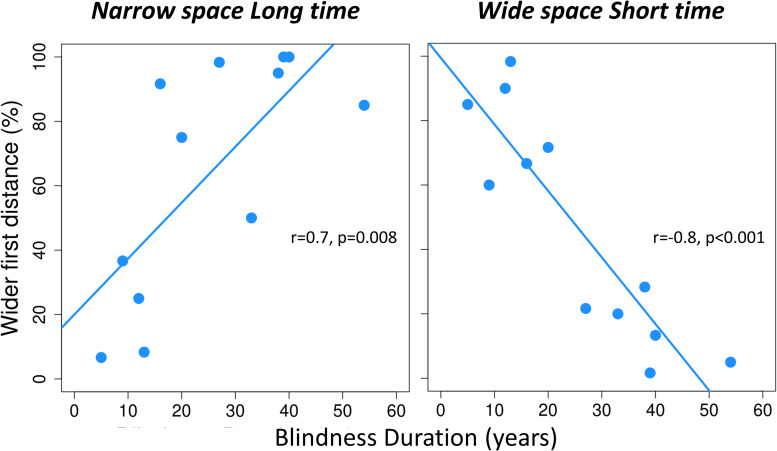
For each conflicting condition of the spatial bisection task, the perceived localization of S2 is plotted against years of blindness duration. For each conflicting condition (narrowSpace_longTime, wideSpace_shortTime), percentage of trials in which the first distance is reported as wider (i.e., perceiving S2 as played from the right) is plotted against years of blindness duration. Narrow and wide first spatial distances mean that S2 was played from the left (-4.5°) or right (+ 4.5°) side of participants respectively. Light blue lines indicate significant correlations. For each correlation, we report Pearson correlation coefficient (r) and significance level (p).